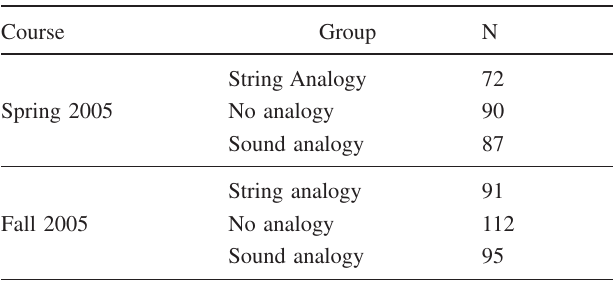
TABLE I. Two treatment groups (cid:1) string and sound (cid:2) and control group (cid:1) no analogy (cid:2) for the initial (cid:1) spring (cid:2) and follow-up (cid:1) fall (cid:2)